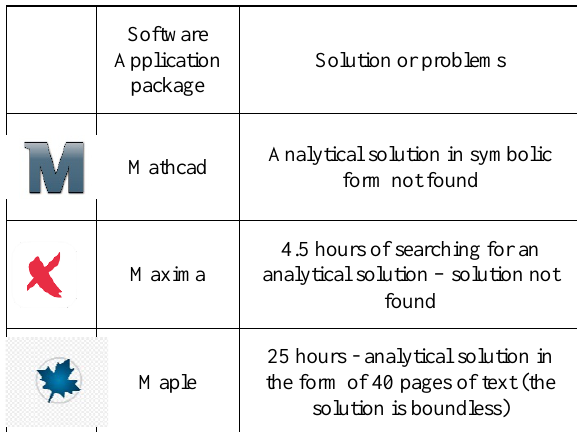
Table 1. Results of solving the Rodrigues equation by software